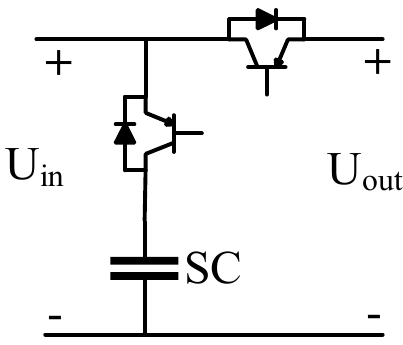
Figure 20. The plug-in converter topology with supercapacitor.